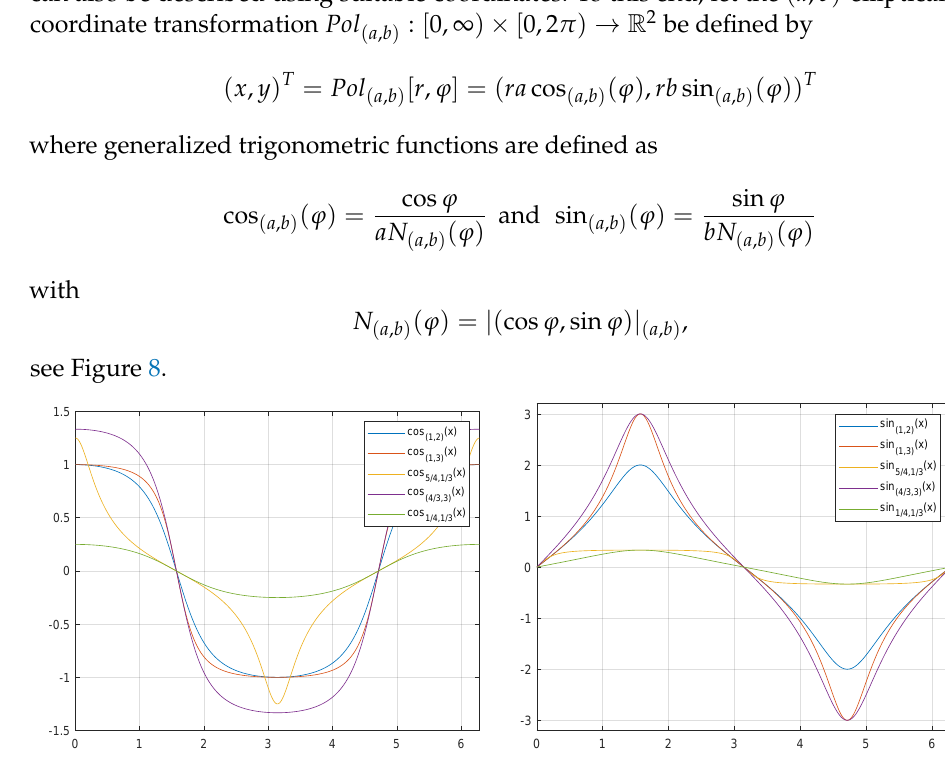
Figure 8. The elliptical trigonometric functions cos ( a , b ) and sin ( a , b ) . This transformation is a.e. invertible